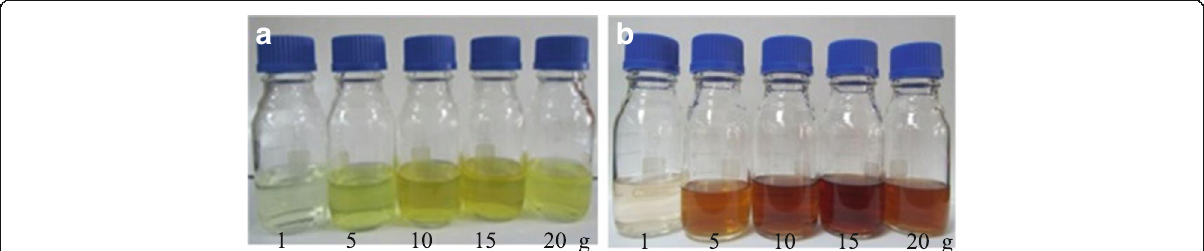
Fig. 2 Color change observed in cell-free fungal extract of Trichoderma longibrachiatum biomass after exposure to AgNO 3 ions at 28 °C with a agitation or b without agitation